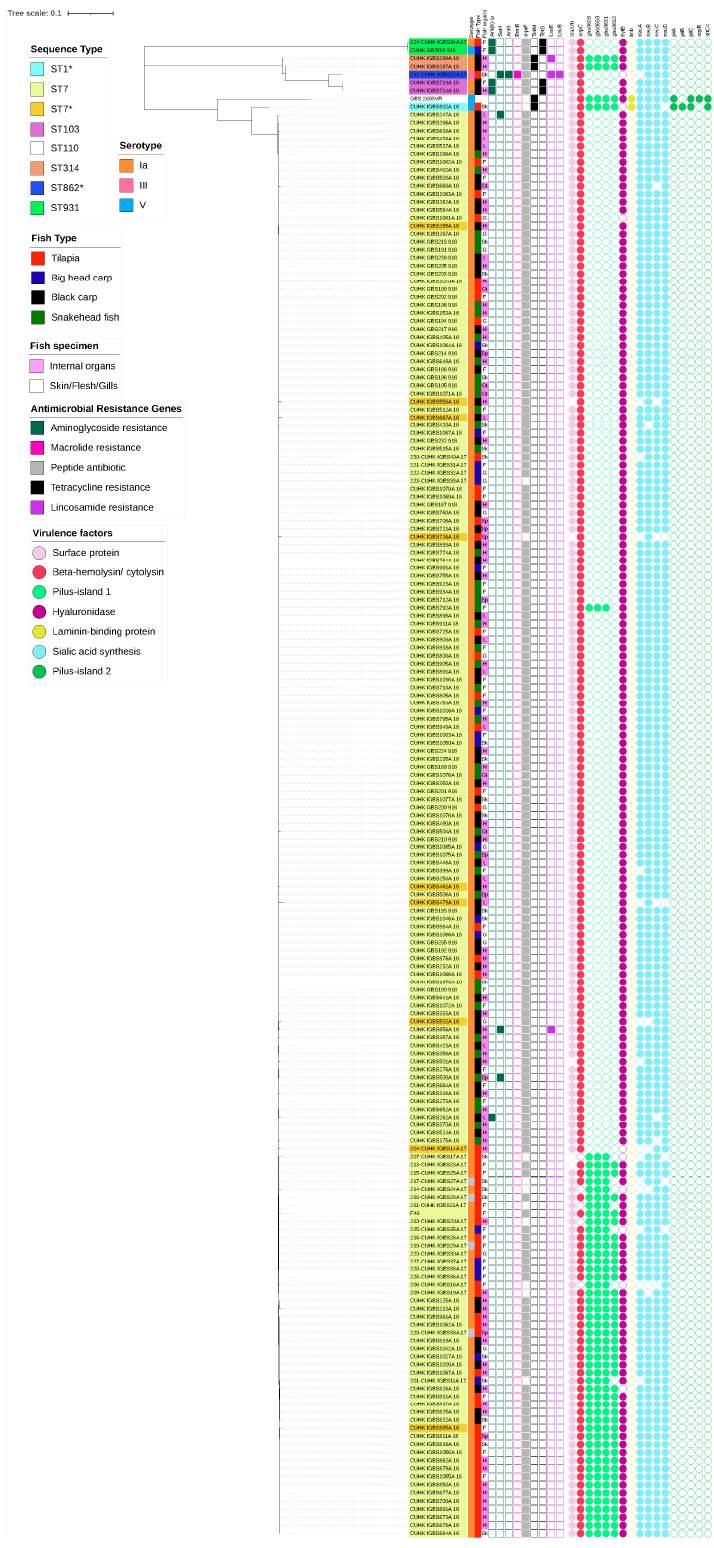
Figure 2. Phylogeny of fish GBS and profiles’ molecular characteristics. Coloured ribbons on the labels indicate the sequence type (ST), while the coloured strip adjacent to the labels shows the serotypes. The type of fish and specimen sampled are also noted adjacent to the serotype. Antimicrobial resistance genes and virulence factors are noted in squared boxes and circles, respectively. Sequence types with an asterisk (*) indicate strains with locus variants of the sequence types